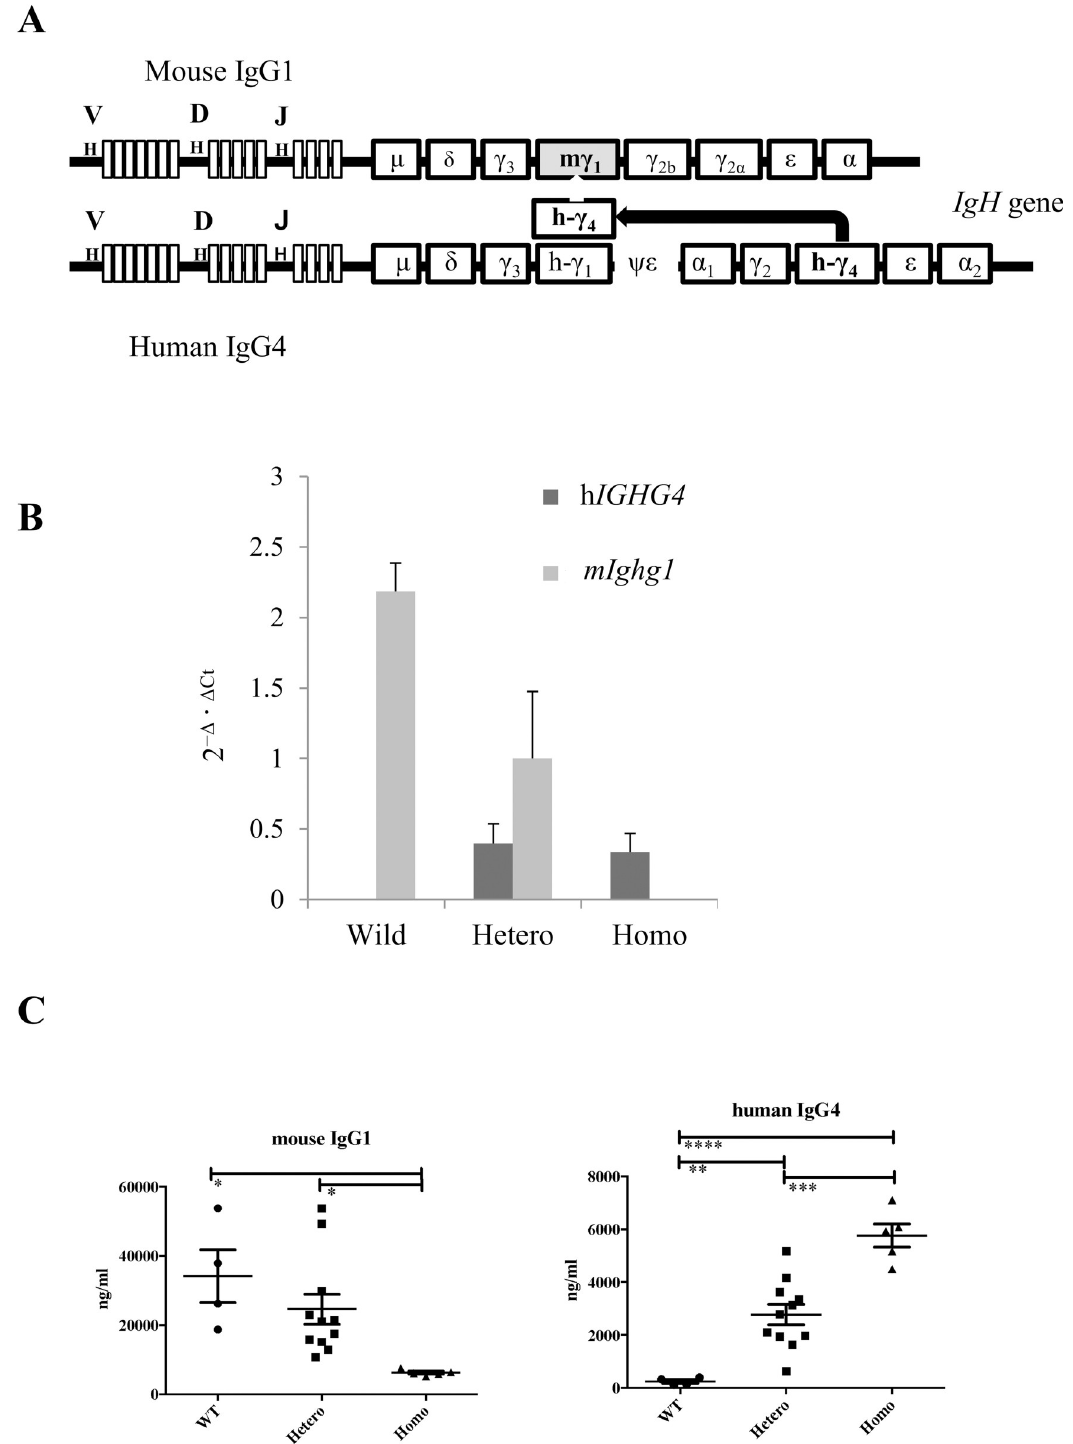
Fig 1. Introduction of the human IGHG4 gene into mice. A. Genetic design of the human IGHG4 knock-in mouse. B. Quantitative real-time PCR of h IGHG4 and m Ighg1 in splenocytes. Data were calculated by the 2- Δ � Δ Ct method using GAPDH gene as the control and h IGHG4 and m Ighg1 genes as the target genes. C. Serum concentration of mIgG1 and hIgG4 in 5 to 8-week-old mice as assessed by enzyme-linked immunosorbent assay (ELISA). � : P < 0.05, �� : P < 0.01, ��� : P < 0.001, ���� : P < 0.0001 by Bonferroni’s multiple t-test (all pairs). h IGHG4 , human IGHG4 gene; m Ighg1 , mouse Ighg1 gene. Hetero, heterozygous; Homo, homozygous; WT, wild-type. https://doi.org/10.1371/journal.pone.0279389.g001 PLOS ONE | https://doi.org/10.1371/journal.pone.0279389 February 10,